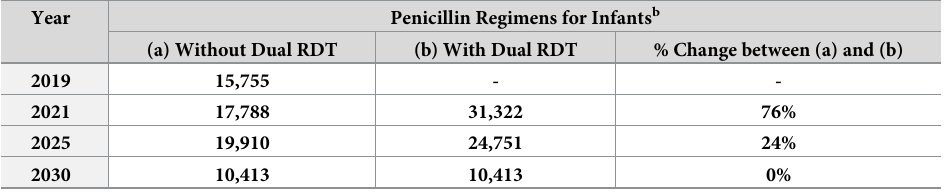
Table 3. Demand for treatment regimens for infants.